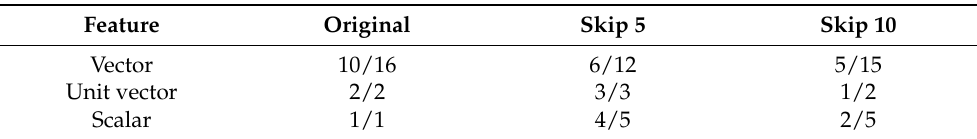
Table 3. Ratio of errors due to (inherent) Re-ID to the total number of failures for global tracklet matching in cameras 2 and 3 FOV environments.